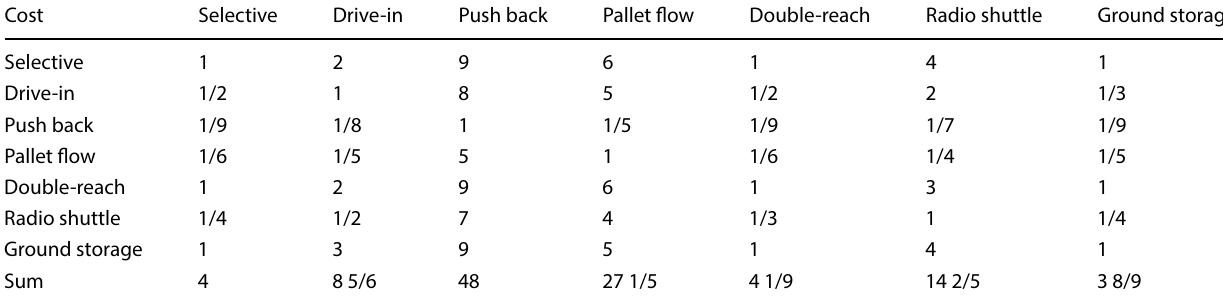
Table 8 Comparison between the alternatives in term of cost Cost Selective Drive-in Push back Pallet flow Double-reach Radio shuttle Ground storage Selective 1 2 9 Drive-in 1/2 1 Pallet flow 1/6 1/5 5 Double-reach